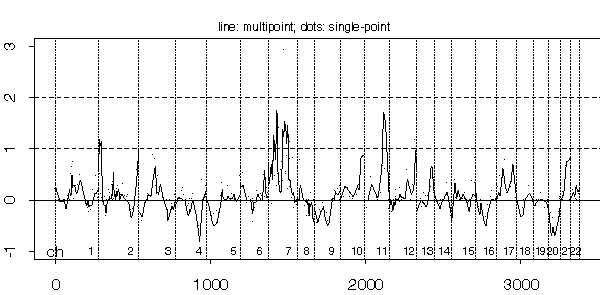
K-C LOD scores for NPLall for microsatellite markers. Solid lines correspond to multipoint analysis and dots correspond to single-point analysis.